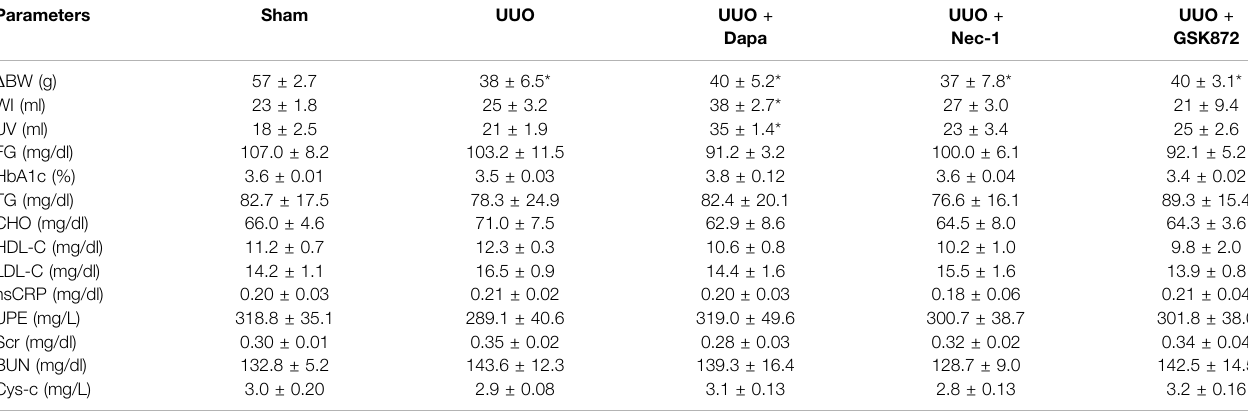
TABLE 1 | Basic parameters in the experimental groups.